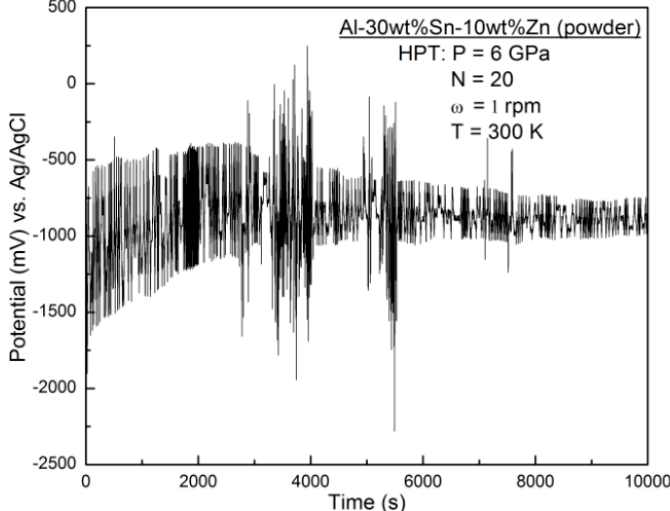
Figure 11. Open circuit potential (OCP) curve in water at room temperature for the Al-30wt %Sn-10wt %Zn alloy processed by HPT for N = 20. Potential was measured with reference to the Ag/AgCl electrode.